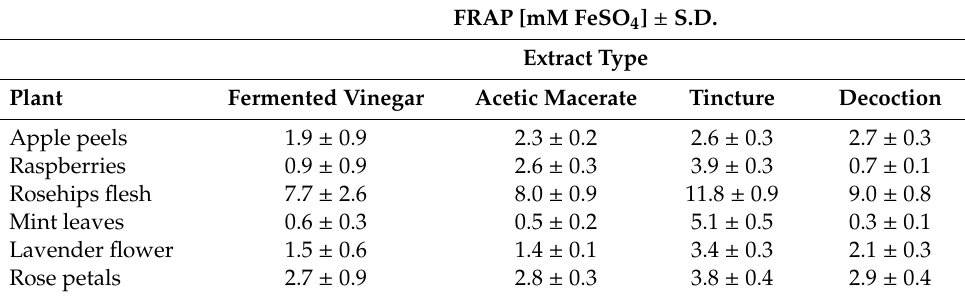
Table 4. The antioxidant power of fruit and herbal extracts measured using ferric reducing antioxidant power (FRAP) expressed as molar concentration of equivalents of FeSO 4 .